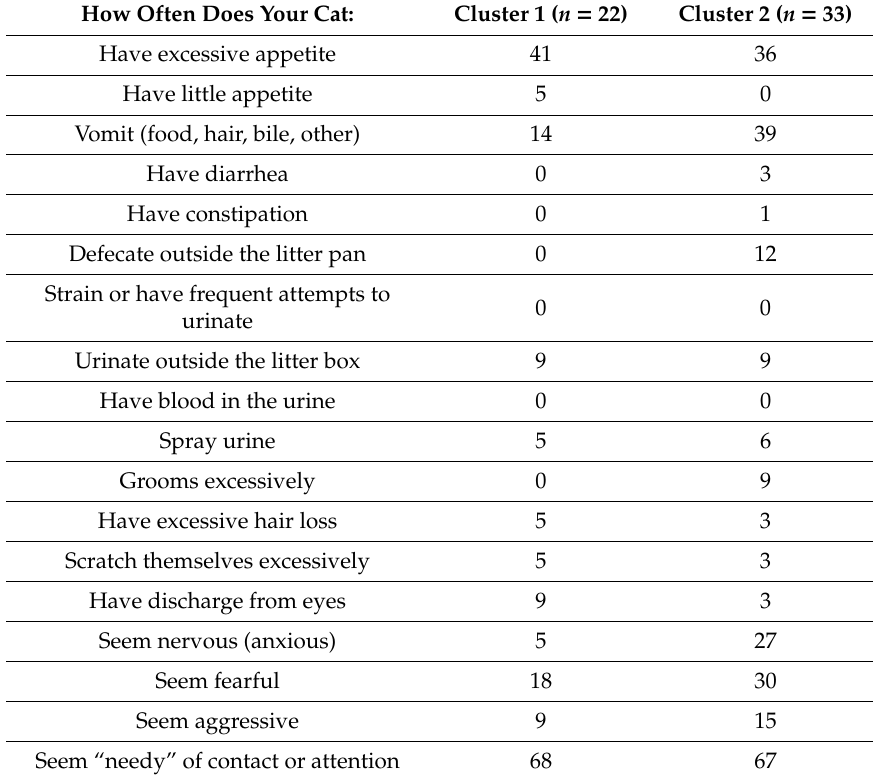
Table 2. Guardian-reported frequency of sickness behaviors by cluster (% reporting at least 1 /